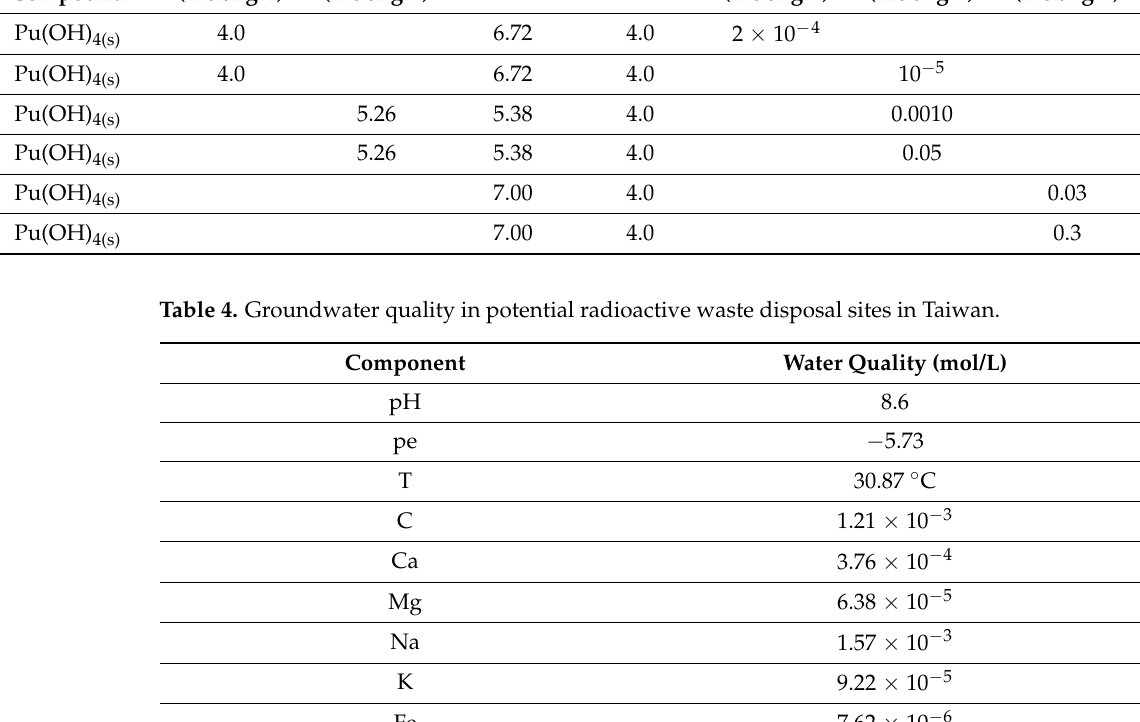
Table 3. Initial conditions of the aqueous solution for the speciation and solubility calculation of Pu(OH) 4(s) . Solution No.